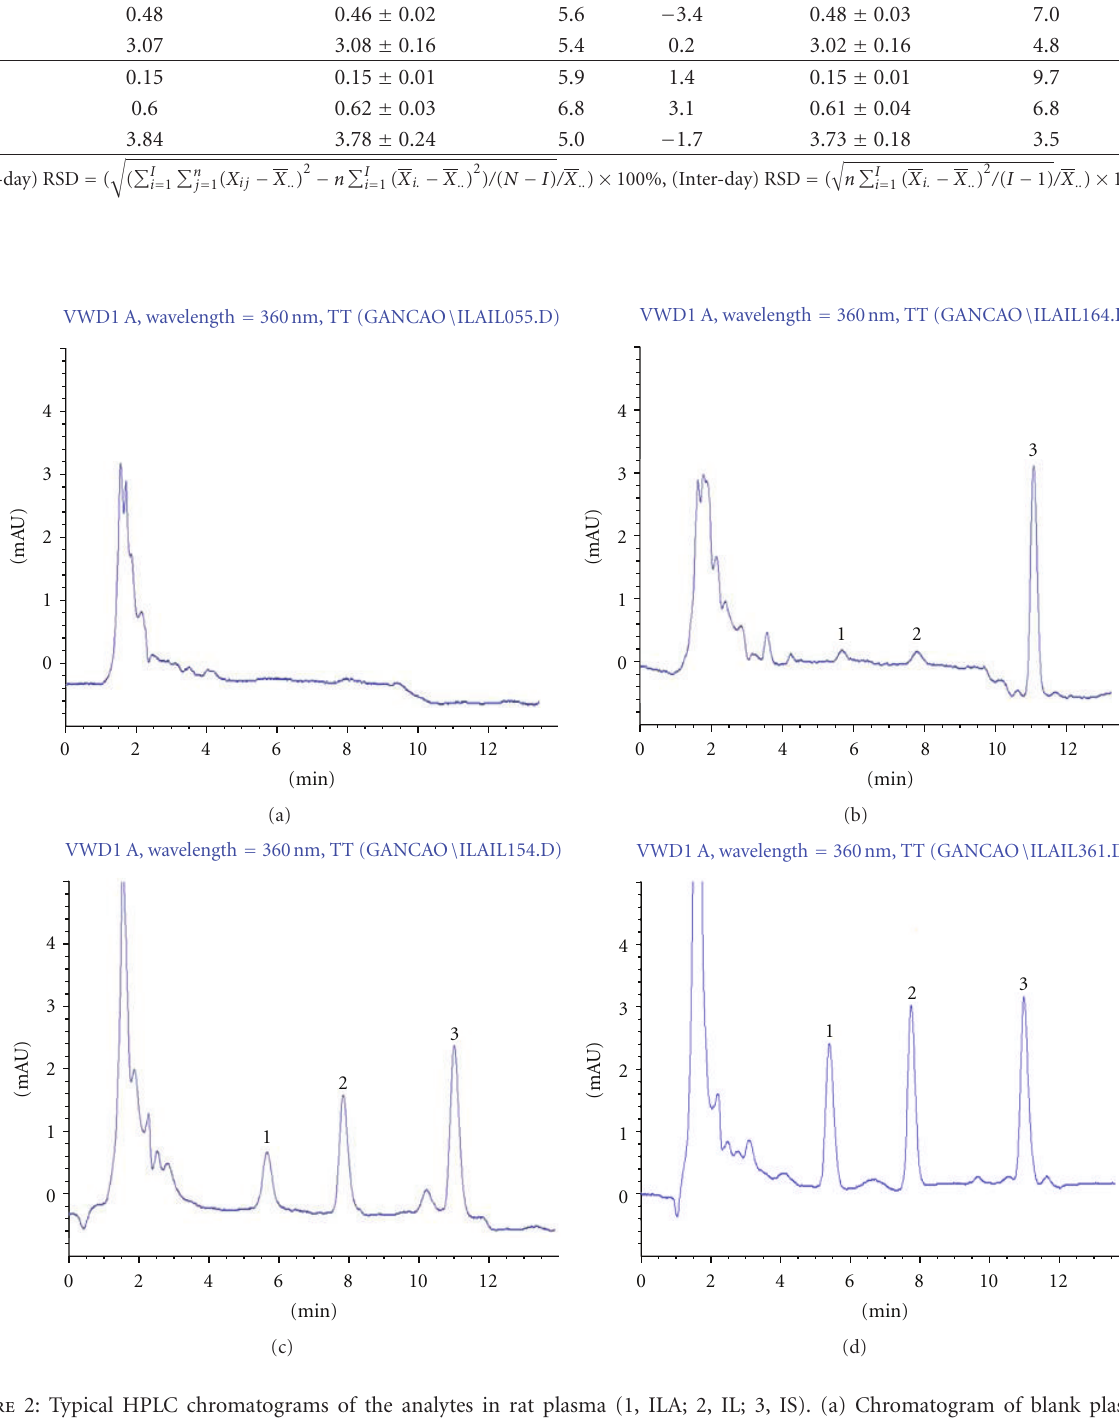
Figure 2: Typical HPLC chromatograms of the analytes in rat plasma (1, ILA; 2, IL; 3, IS). (a) Chromatogram of blank plasma; (b) chromatogram of plasma sample at LLOQ level (ILA 0.060 µ g/mL and IL 0.075 µ g/mL); (c) chromatogram of plasma sample at middle QC level (ILA 0.48 µ g/mL and IL 0.60 µ g/mL); (d) chromatogram of plasma sample obtained from rat (No. 2) at 1h after an oral administration of Zhigancao extract (ILA 0.78 µ g/mL and IL 1.04 µ g/mL by